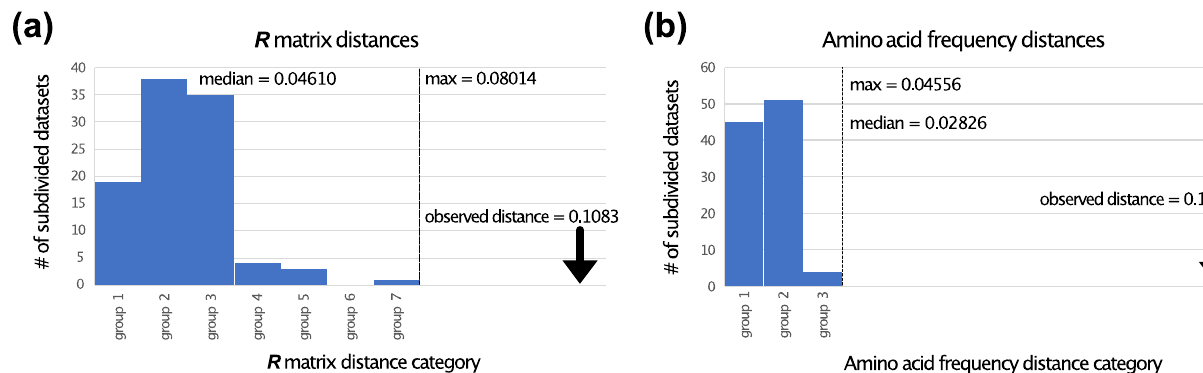
Figure 2. Results of the 100 randomly subdivided datasets showing Euclidean distances between ( a ) relative exchangeabilities ( R matrix parameters) and ( b ) amino acid frequencies. The distributions were compared to the observed values for the TM versus ExM distances (black arrows). Although group boundaries for the histogram are arbitrary, the scale of the x -axis places the observed distance for the empirical data correctly relative to distances for random subdivisions.